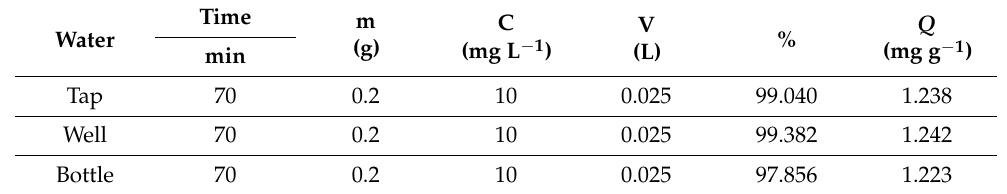
Table 6. The removal percentage and adsorption capacity at fixed parameters for environmental